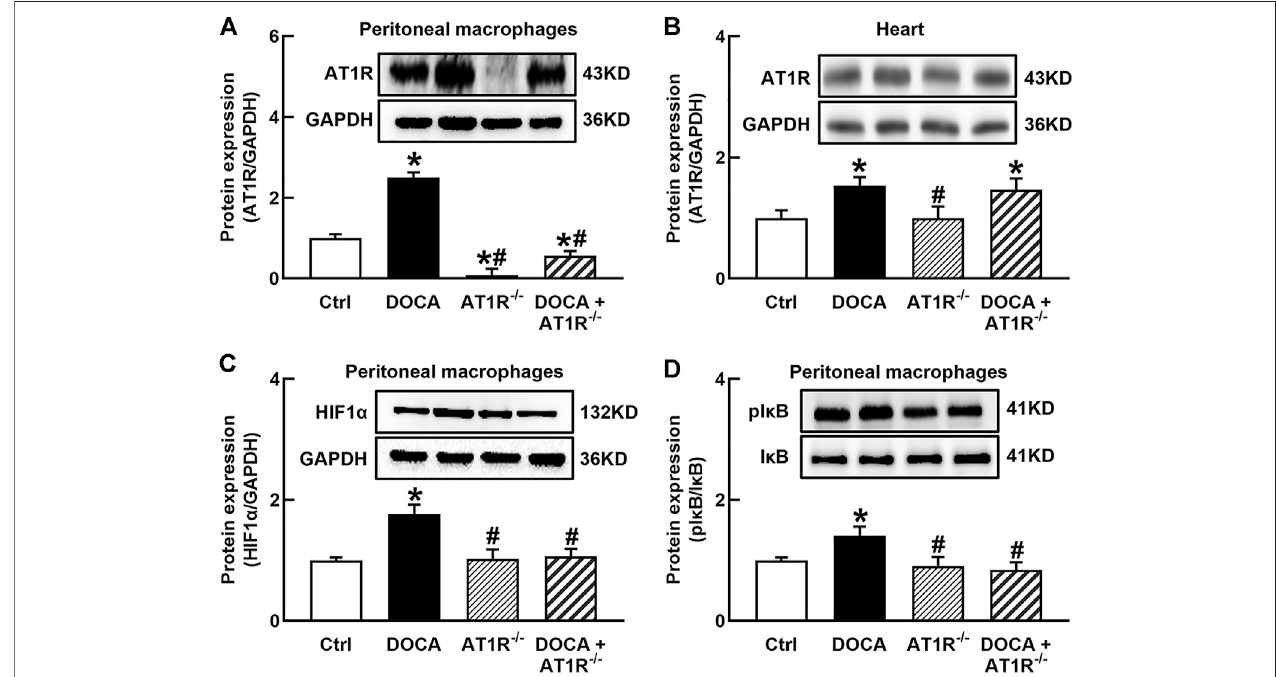
FIGURE 6 | Speci fi c myeloid AT1R KO reduced the expression of AT1R (A) , HIF1 α (C) , and the ratio of pI κ B/I κ B (D) in the peritoneal macrophage of DOCA mice. MyeloidAT1RKOdidnotsigni fi cantlyaffect AT1Rexpressionintheheart (B) .Statisticalcomparisonswerecarriedoutwithtwo-way ANOVAfollowedbytheTukeypost hoc test. Data were expressed as mean ± SEM. N = 6, * p < 0.05 vs. control mice, # p < 0.05 vs. DOCA mice.